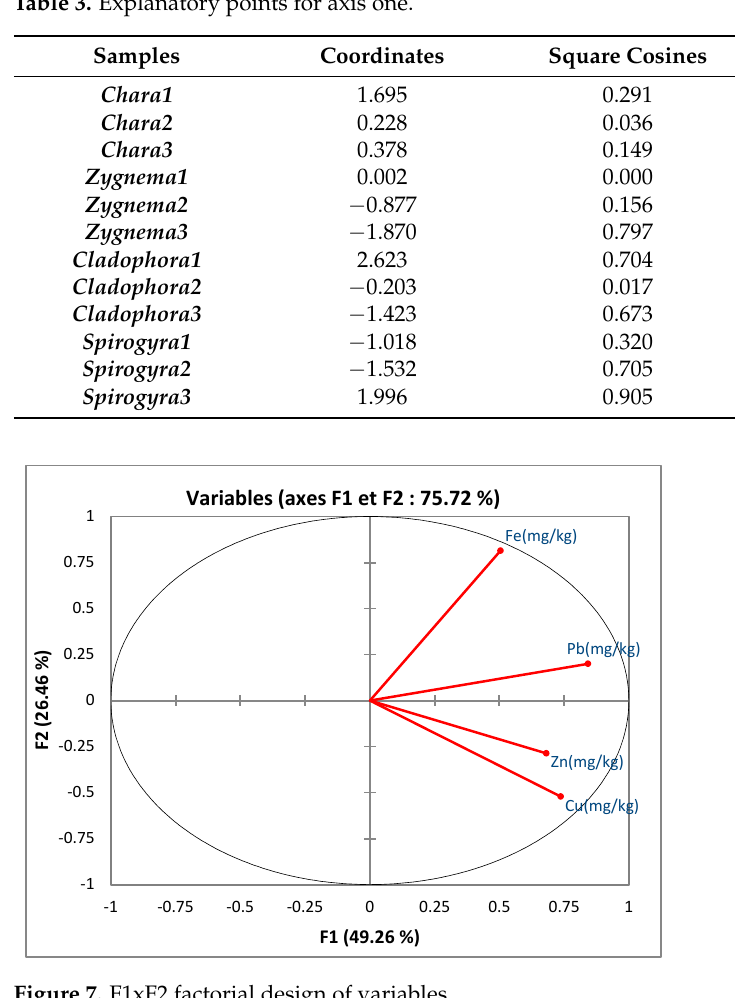
Figure 8. F1xF2 factorial design of individuals (samples).